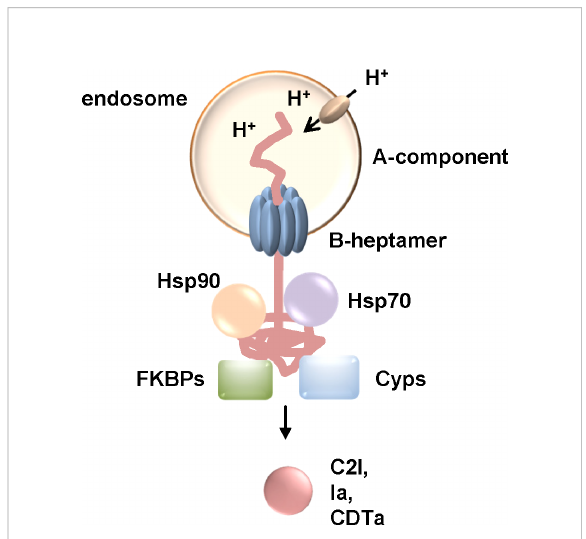
FIGURE 5 The activity of Hsp90, Hsp70, Cyps and FKBPs is required for the translocation of the enzyme components C2I, Ia and CDTa of clostridial binary C2, Iota and CDT toxins, respectively. These clostridial binary toxins are taken up via receptor-mediated endocytosis. Acidi fi cation of endosomes leads to conformational changes resulting in pore formation of the B-heptamer into the endosomal membrane. The enzyme components are at least partially unfolded and translocate through the narrow pore into the cytosol. If the activity of Hsp90, Hsp70, Cyps or FKBPs is inhibited by speci fi c pharmacological inhibitors, less enzyme molecules reach the cytosol and cells are protected from intoxication (Haug et al., 2003a; Haug et al., 2004; Kaiser et al., 2009; Kaiser et al., 2011; Kaiser et al., 2012; Ernst et al., 2015; Ernst et al., 2016; Ernst et al., 2017a). (Cyps, cyclophilins; FKBPs, FK506-binding